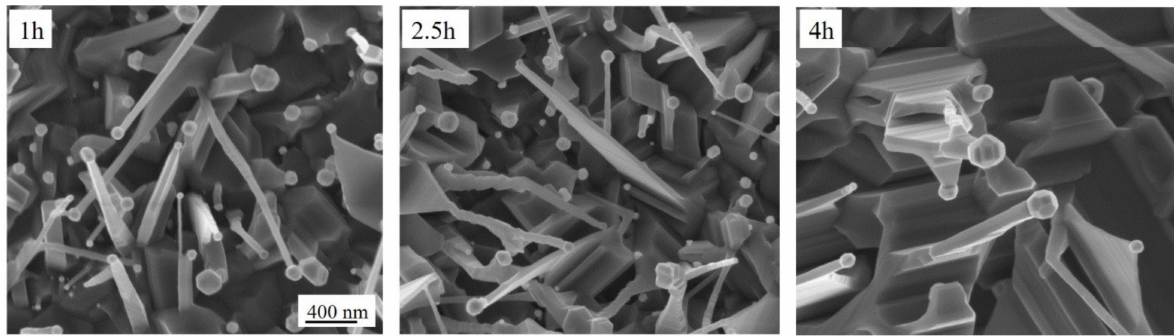
Figure 2. SEM images in plan-view of the TiO 2 NWs grown at 800 ◦ C for different annealing